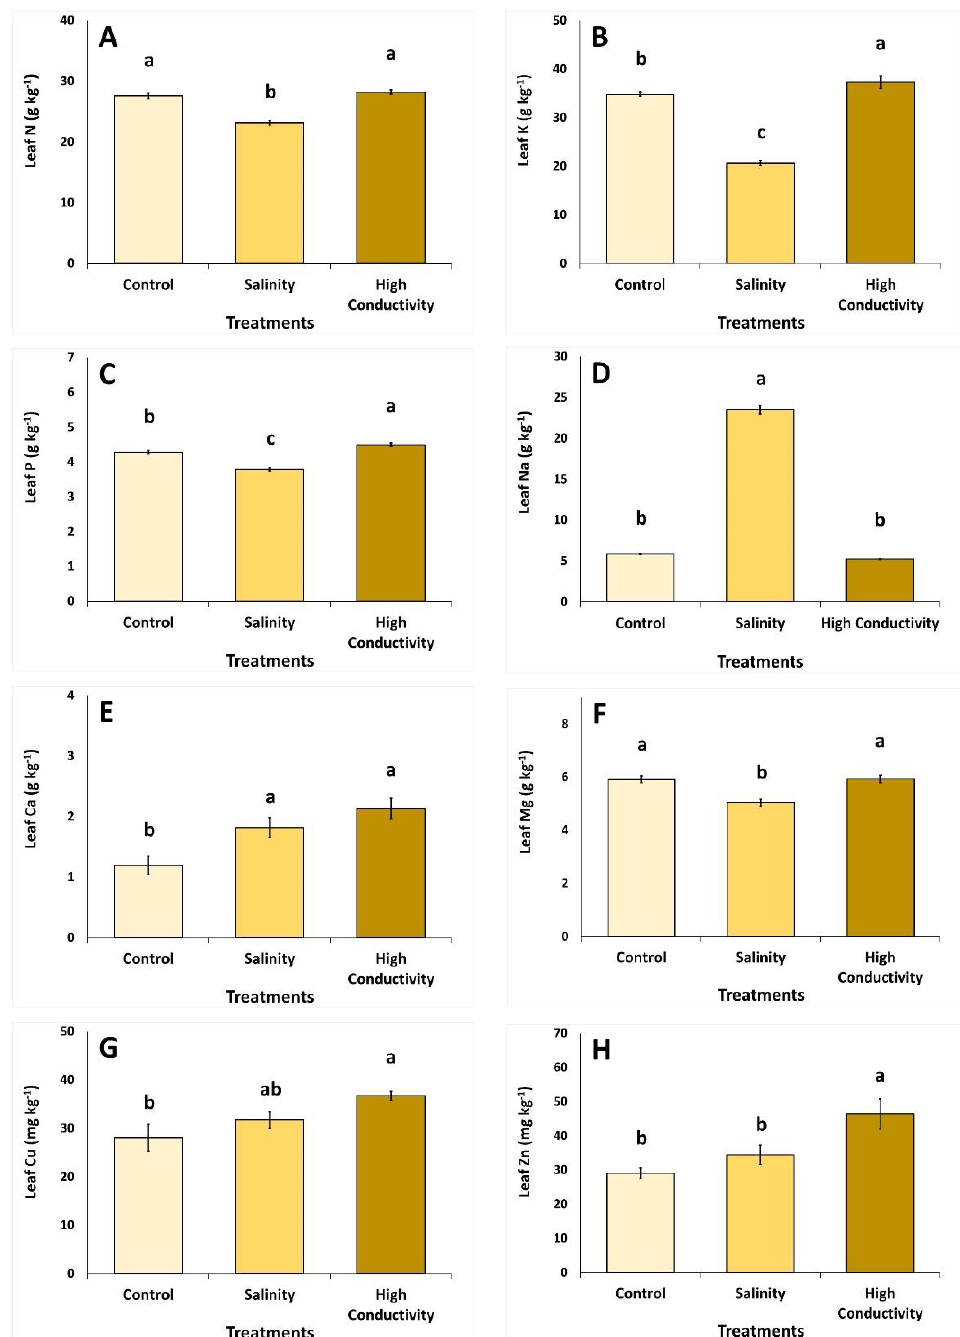
Figure 4. Influence of salinity (75 mM NaCl) and high conductivity (8.5 dS m − 1 ) on the leaf content of macro- and micronu- trients in geraniums grown hydroponically in perlite substrate. ( A ) nitrogen—N, ( B ) potassium—K, ( C ) phosphorus—P, ( D ) sodium—Na, ( E ) calcium—Ca, ( F ) magnesium—Mg, ( G ) copper—Cu and ( H ) zinc—Zn. Significant differences ( p < 0.05) are indicated by different letters above each bar. Error bars show SE (n = 4).